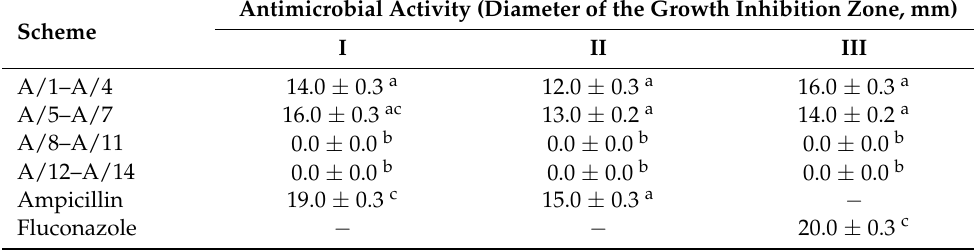
Table 4. The evaluation of the antimicrobial properties of isolated fractions.